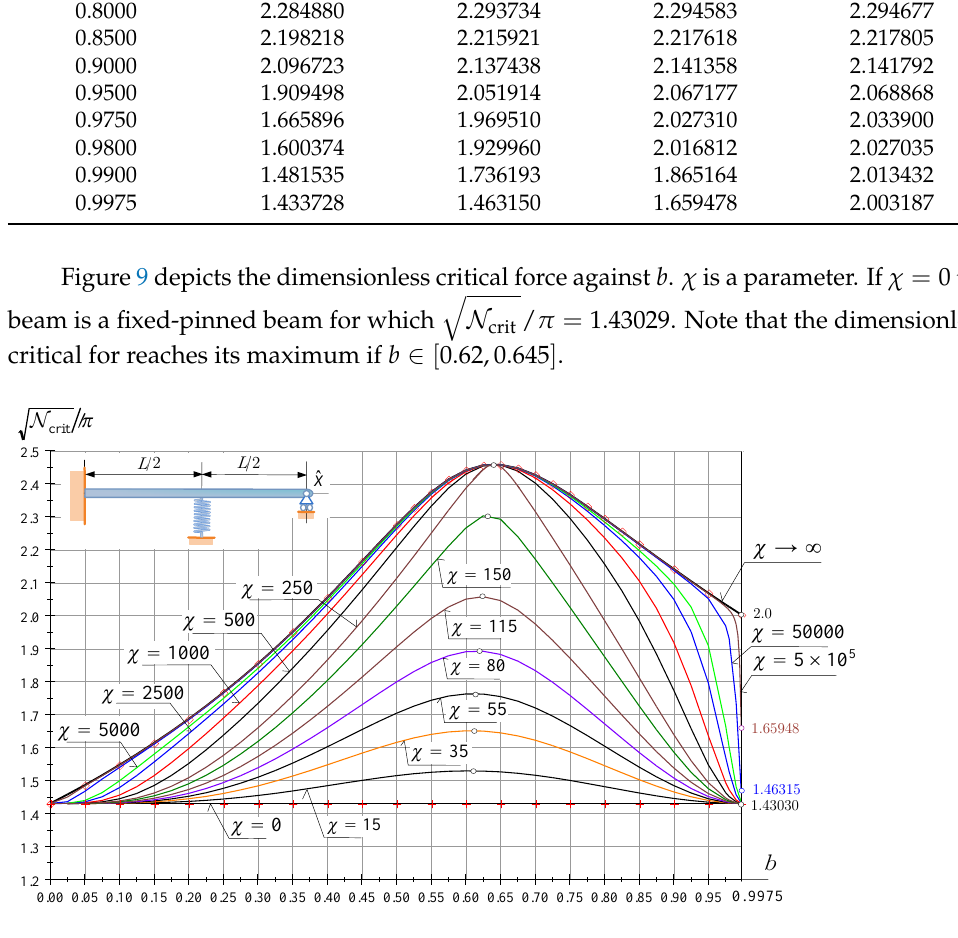
Figure 9. The dimensionless critical force of FssP beams as a function of b ; χ is a